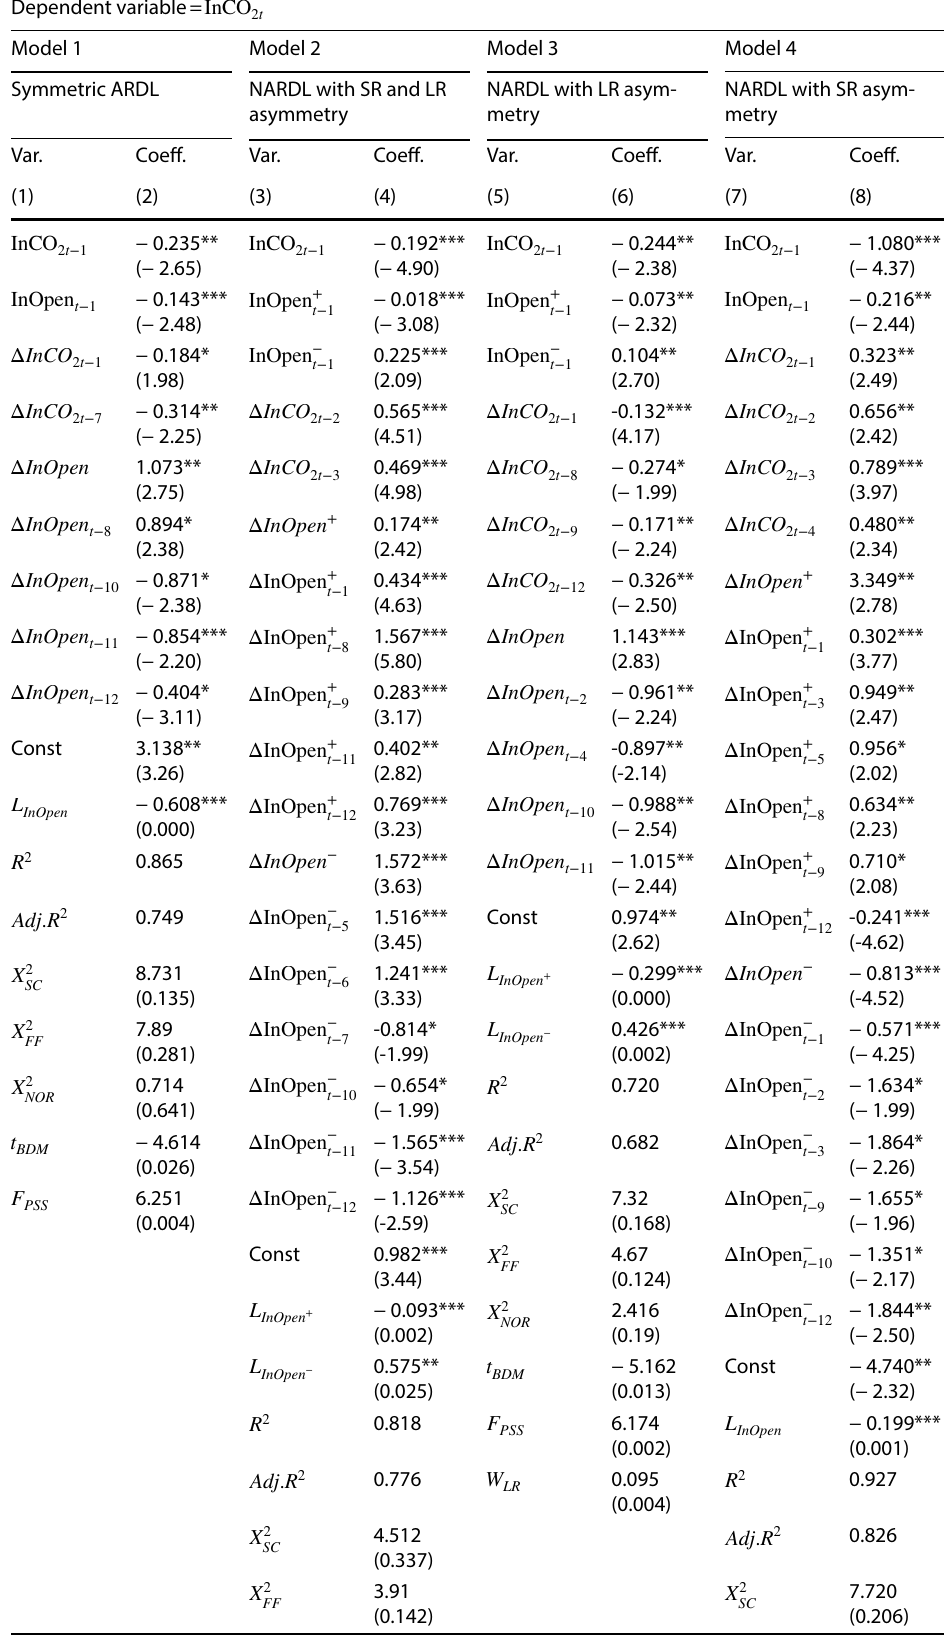
Dependent variable = InCO 2